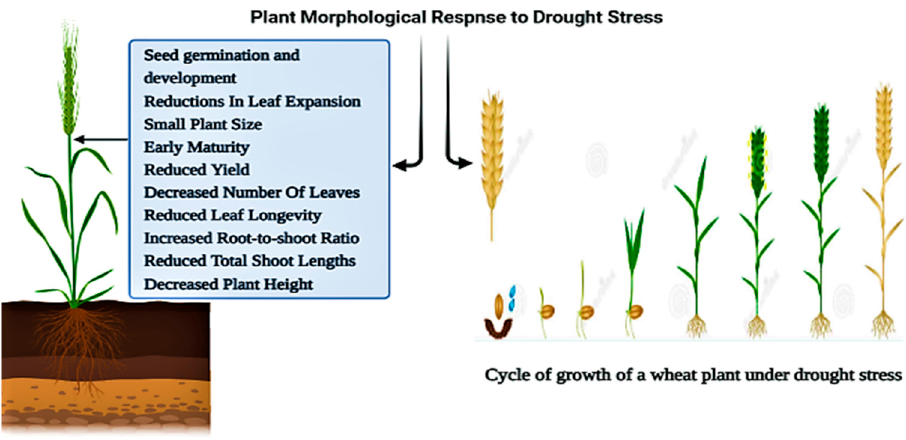
Figure 3. Impact of drought stress on morphological aspects: Cycle of growth of a Triticum aestivum L. plant.